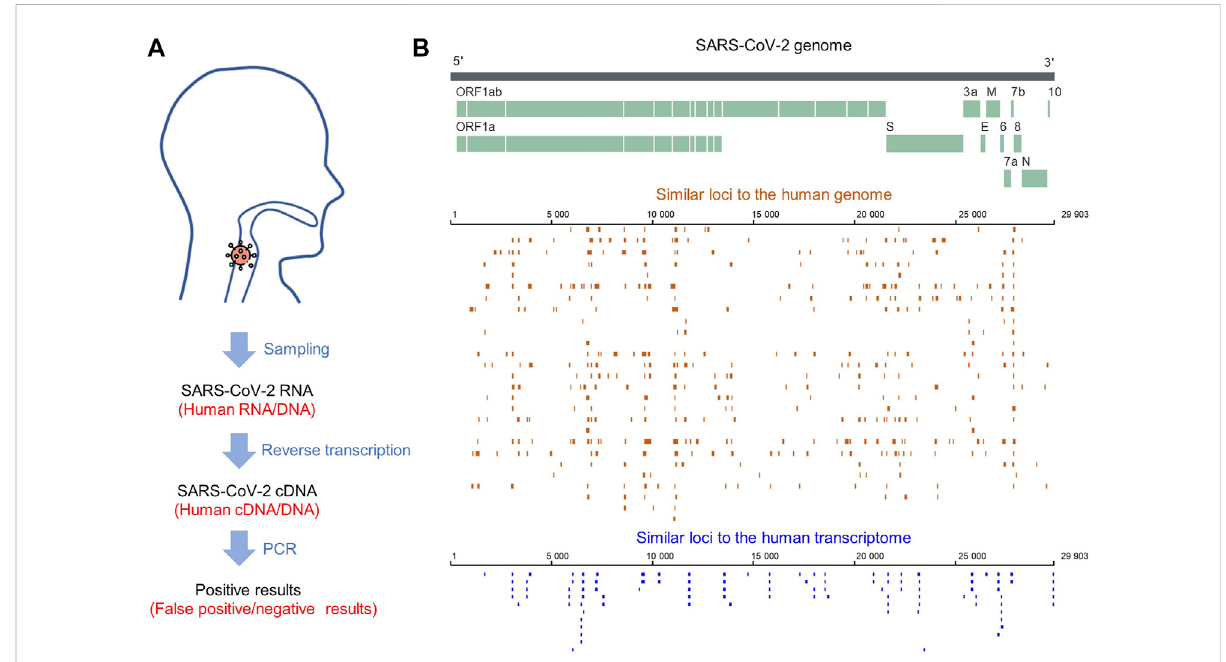
FIGURE 5 (A) SARS-CoV-2 sampling and processing fl ow. (B) Distribution of similar sequences between the SARS-CoV-2 genome and human genome/